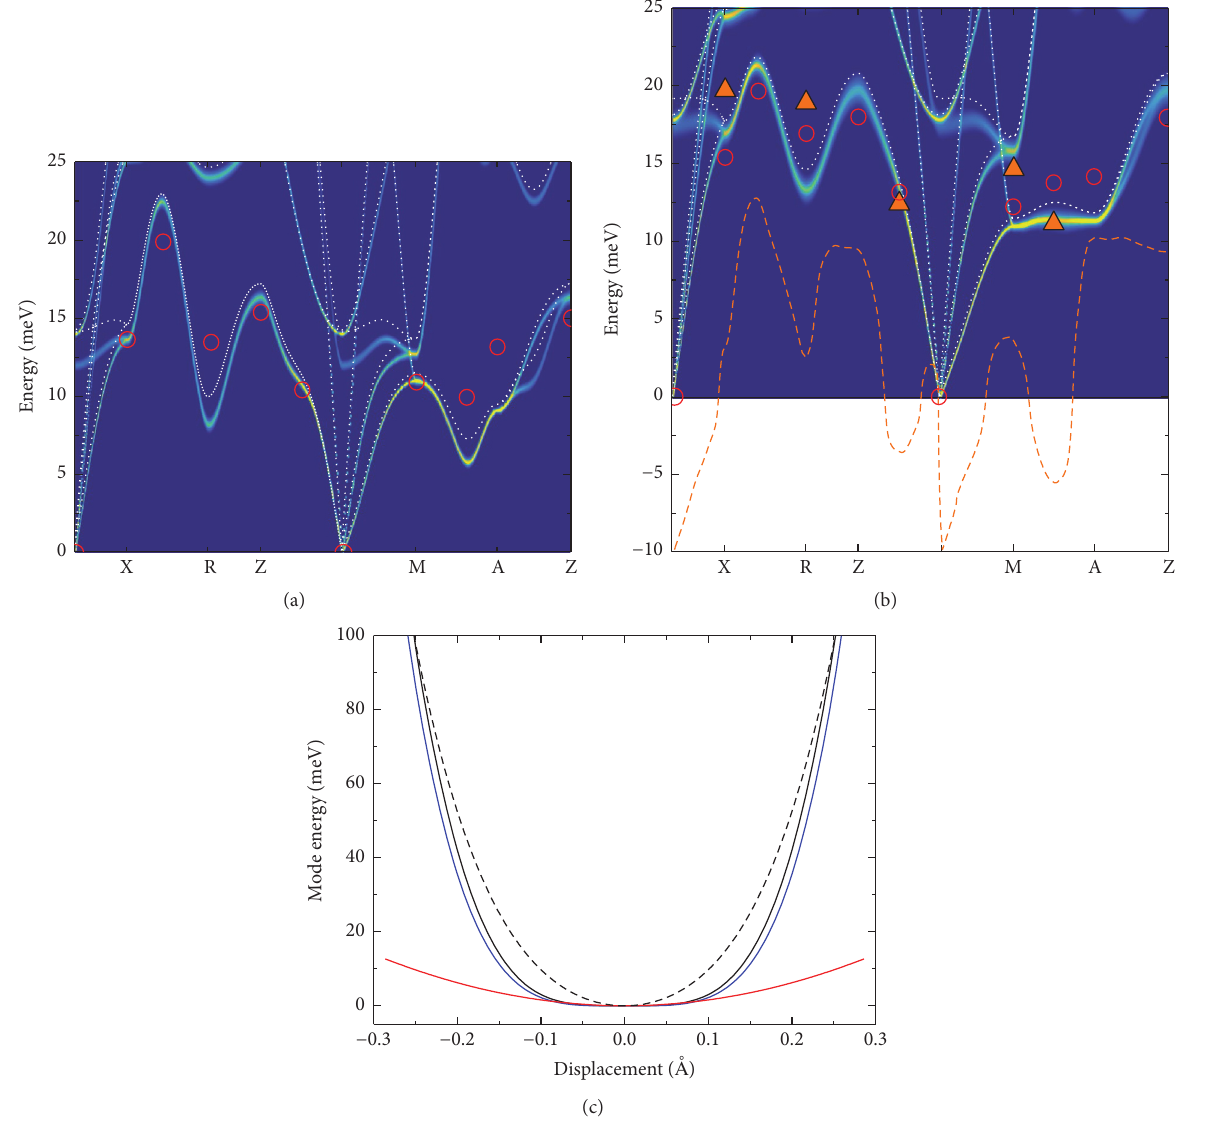
Figure2:DiffusecurvesareTDEPphonondispersionsofrutileTiO 2 below25 meVat(a)300 Kand(b)1373 K,comparedwiththeresultsfrom the FTVAC method (red circles). The white curves are phonon dispersions for the quasiharmonicity plus quartic anharmonicity calculated with all 𝜓 𝑖𝑗𝑘 set to zero in (4). In (b), the dispersions are compared to the quasiharmonic dispersions (orange dashed curve) and the single quartic oscillator model (orange triangles). (c) Frozen phonon potential (black) of TA mode at R point with 𝑞 = (0.5, 0, 0.5) at 1373 K, showing the harmonic component (red) and quartic component (blue). The low temperature potential surface is also shown (dashed black). Reprinted figure with permission from Lan et al. [6]. Copyright by the American Physical